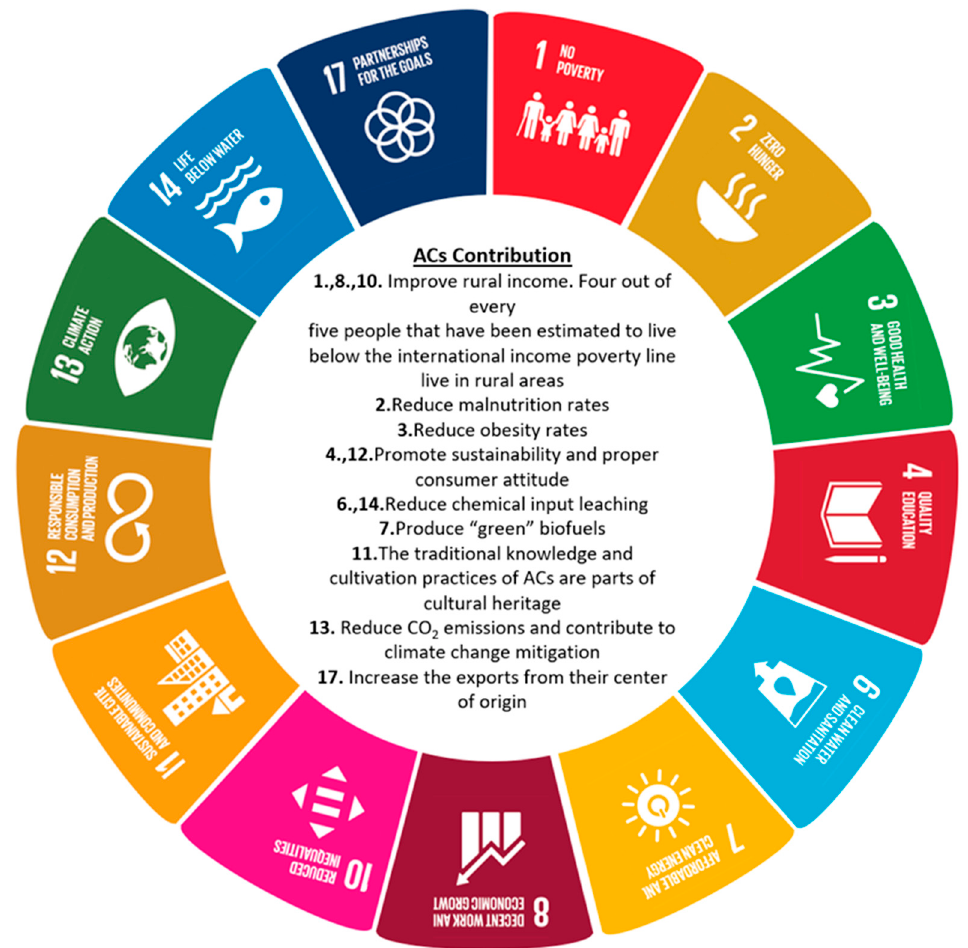
Figure 3. ACs and the SDGs set by the UN. Each SDG is depicted with a different color and is attributed its corresponding number. The contribution of ACs to the SDGs is depicted in the center of the figure next to the corresponding number of each SDG.